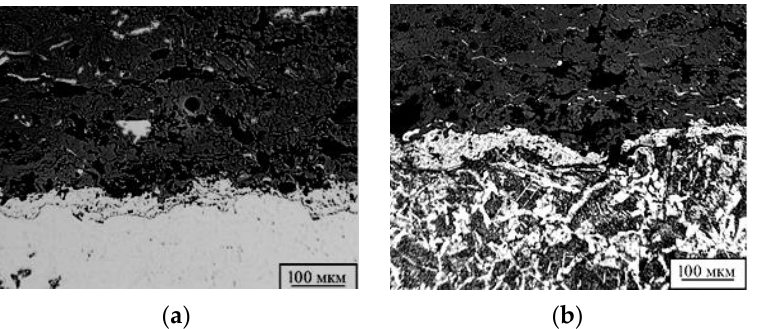
Figure 5. Study of the microstructure of recovered samples using laser technology. ( a )—sample without etching; ( b )—sample after etching.